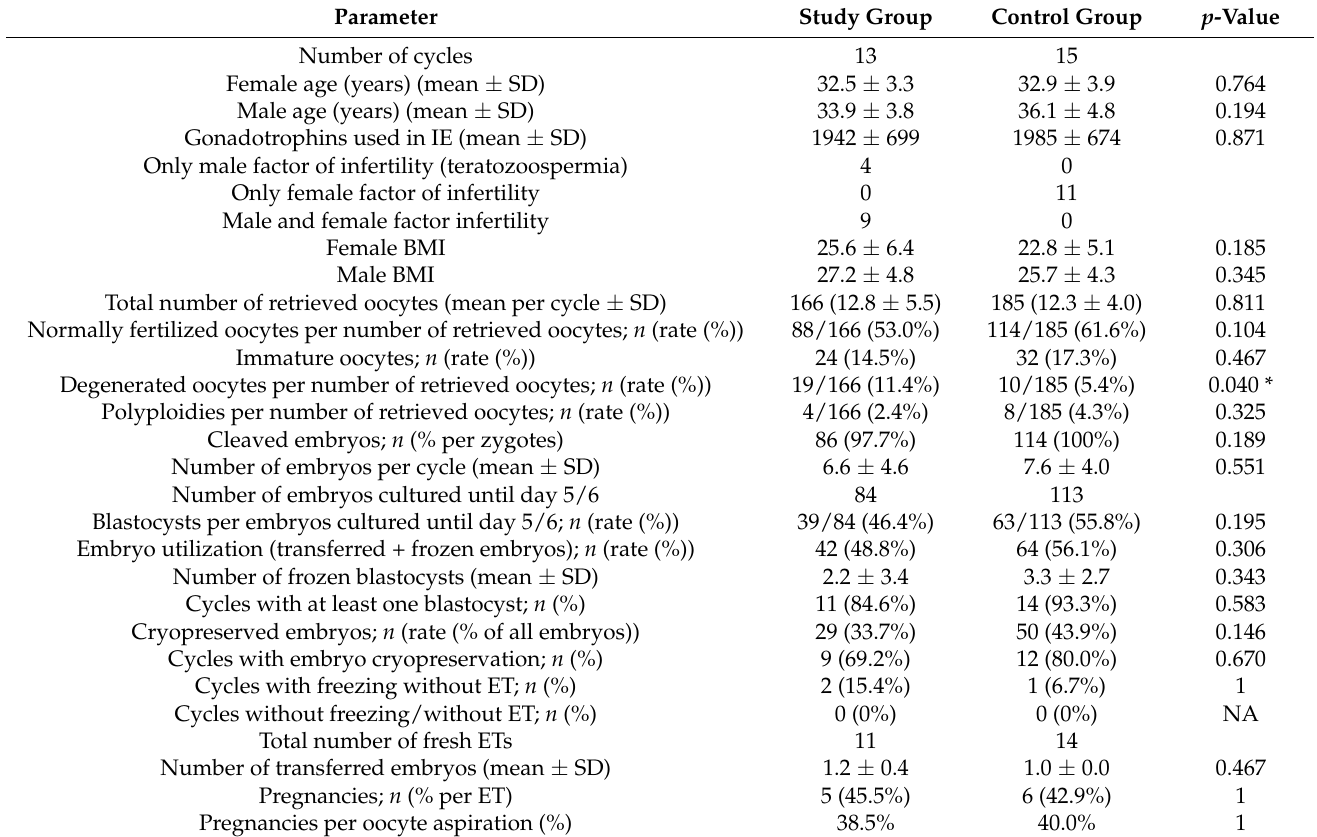
Table 2. Outcomes of the IVF/ICSI cycles in terms of oocytes, embryos and pregnancies. Parameter Study Group Control Group p -Value Number of cycles 13 15 Female age (years) (mean ± SD) 32.5 ±